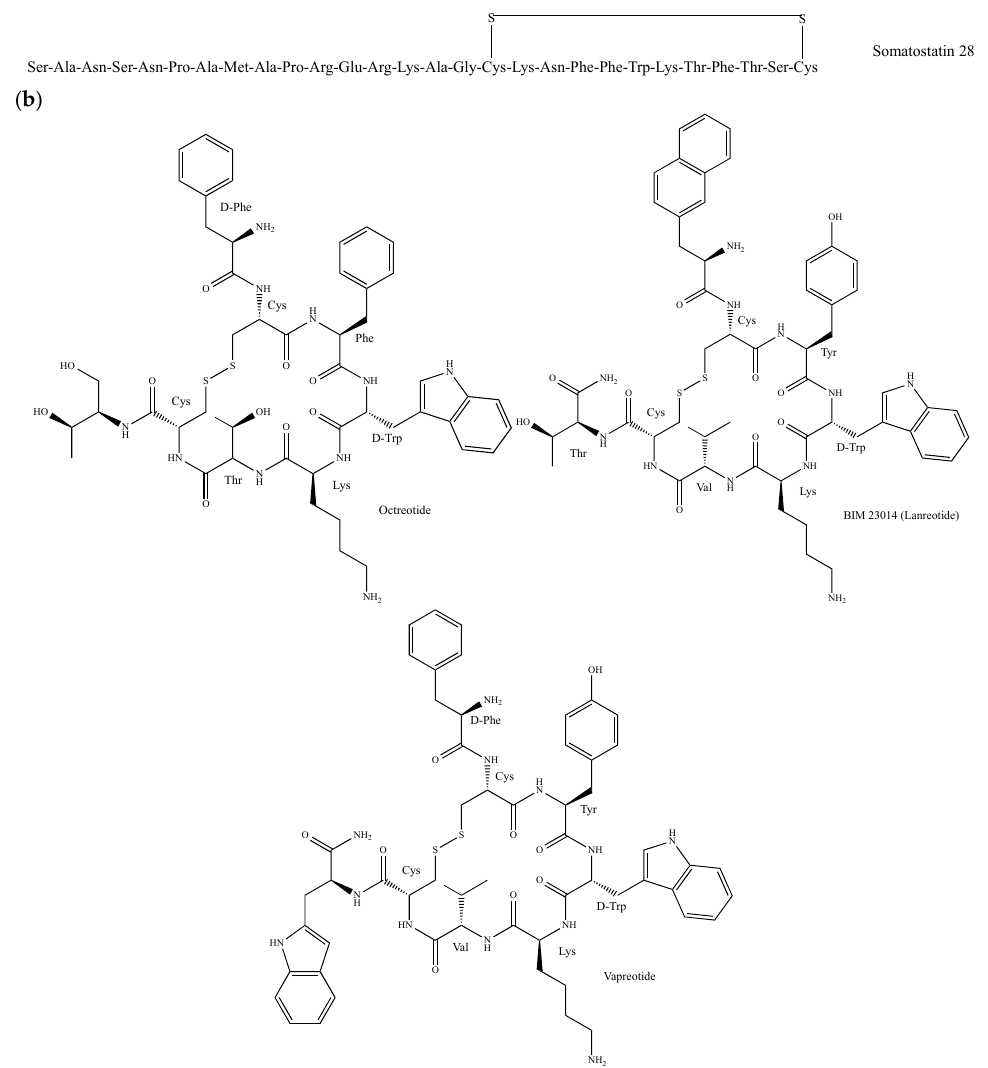
Figure 9. Structure of ( a ) somatostatin-14 and -28 and ( b ) the inhibitors octreotide, BIM 23014 and vapreotide.